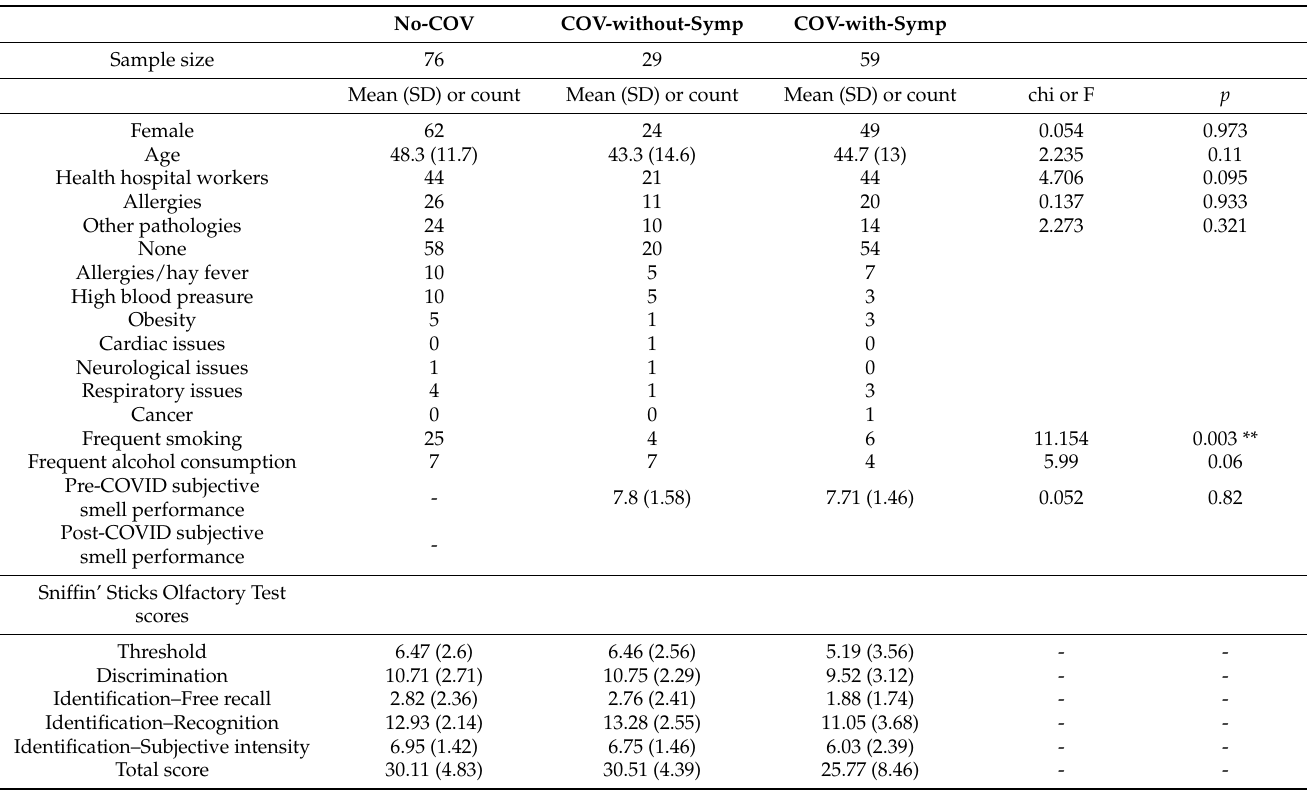
Table 1. Descriptive analysis per COVID-19 subgroups.